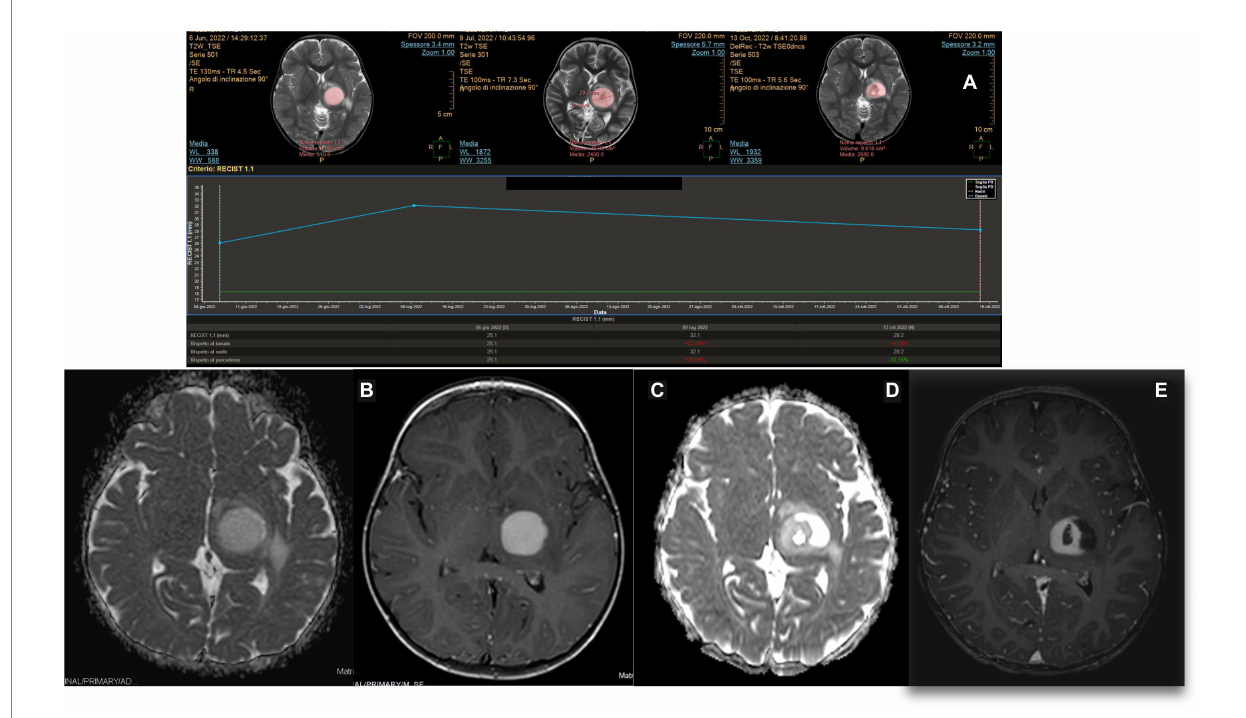
FIGURE 7 (A) MITT Intellispace Portal imaging examination. After 1 month of laser interstitial thermal therapy, when chemotherapy had not yet started, the tumor on diffusion (d) was 22% bigger because of intralesional edema. At 4 months, it was reduced by an overall 22%. (B,C) Pre-operative magnetic resonance imaging (MRI) on ADC and T1 TFE 3D post-enhancement imaging. (D,E) ADC and post-contrast-enhancement MRI obtained 5 months after surgery and after four cycles of chemotherapy demonstrated a cystic evolution of the tumor, with a clear reduction of the contrast enhancement and the involution of the central necrotic